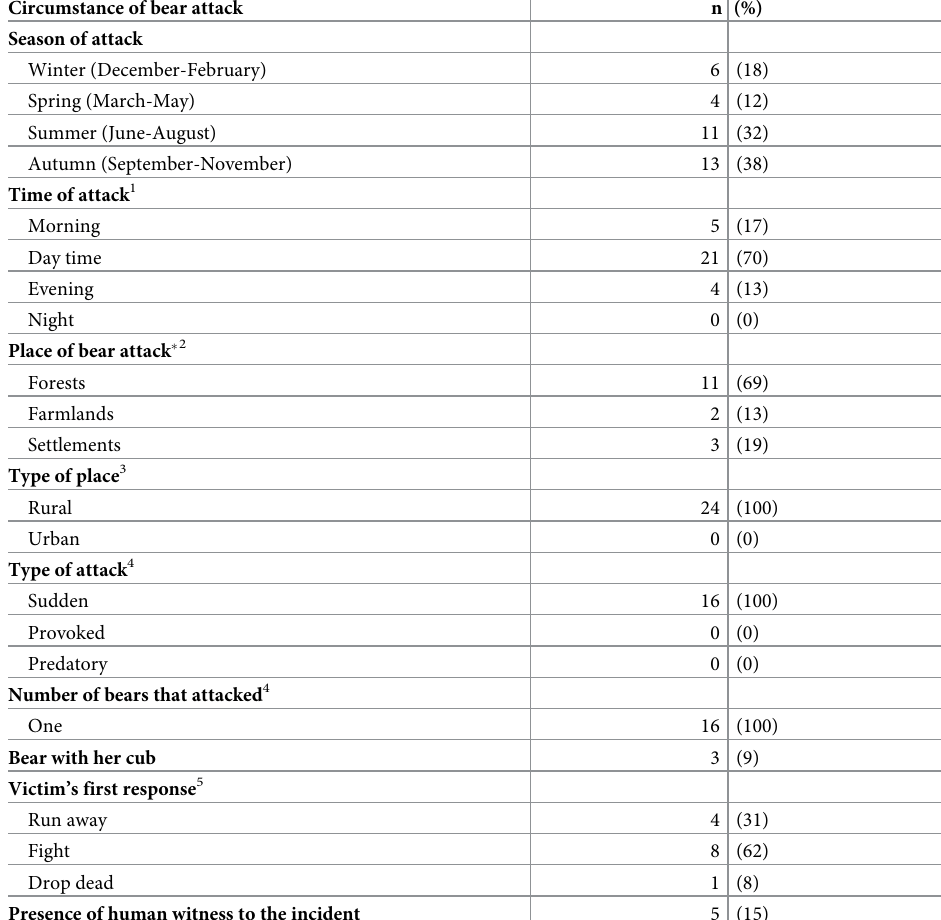
Table 2. The description of the incidents of bear attacks among patients who received care at the Jigme Dorji Wangchuck National Referral Hospital, Bhutan from 2015 to 2019. Circumstance of bear attack n (%) Season of attack